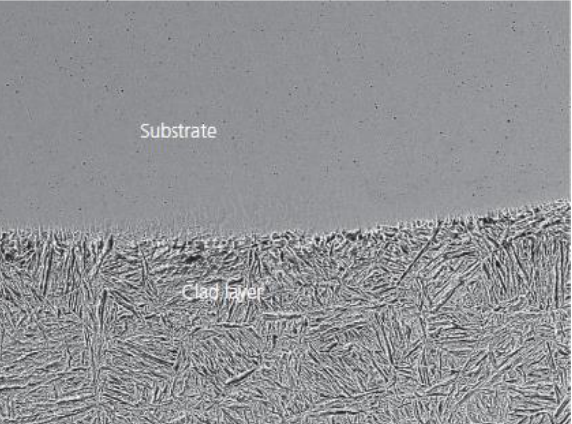
Figure 11. SEM indicates good fusion at the interface between the cladding layer and the interface during LC of martensitic stainless steels on armor steels [81]. ICE Publishing,